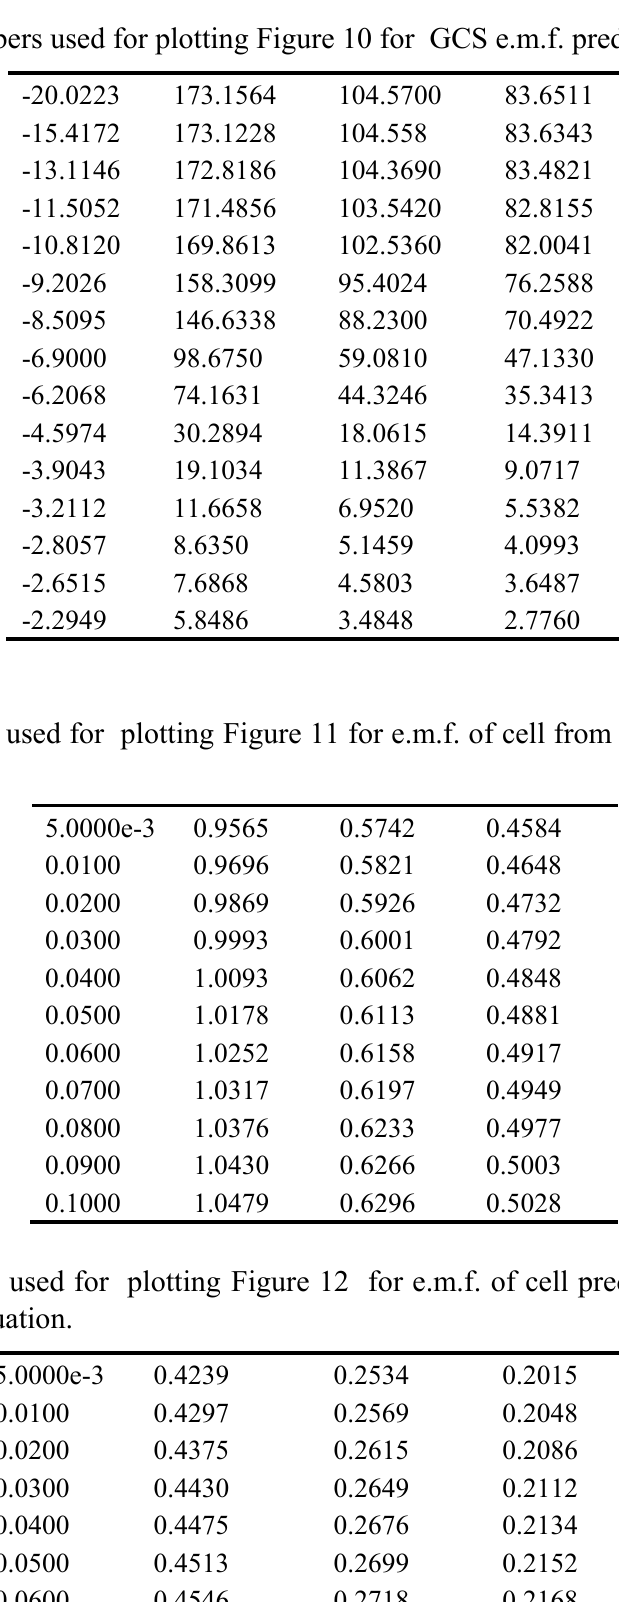
Table 6. Numbers used for plotting Figure 10 for GCS e.m.f. prediction with 